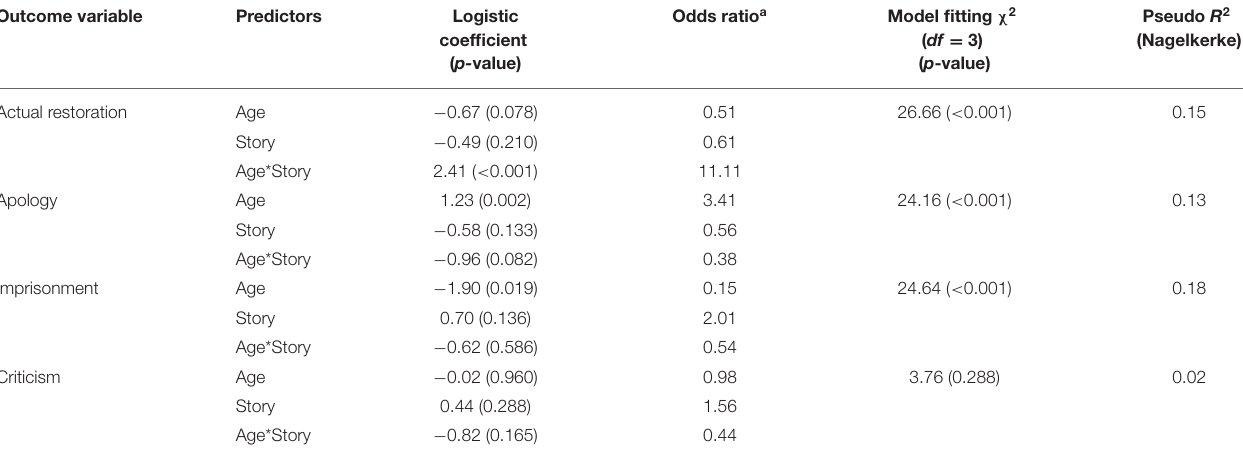
TABLE 2 | Results of ordinal regression analysis with the ranking of actual restoration, apology, imprisonment, and criticism as respective outcome variables. Outcome